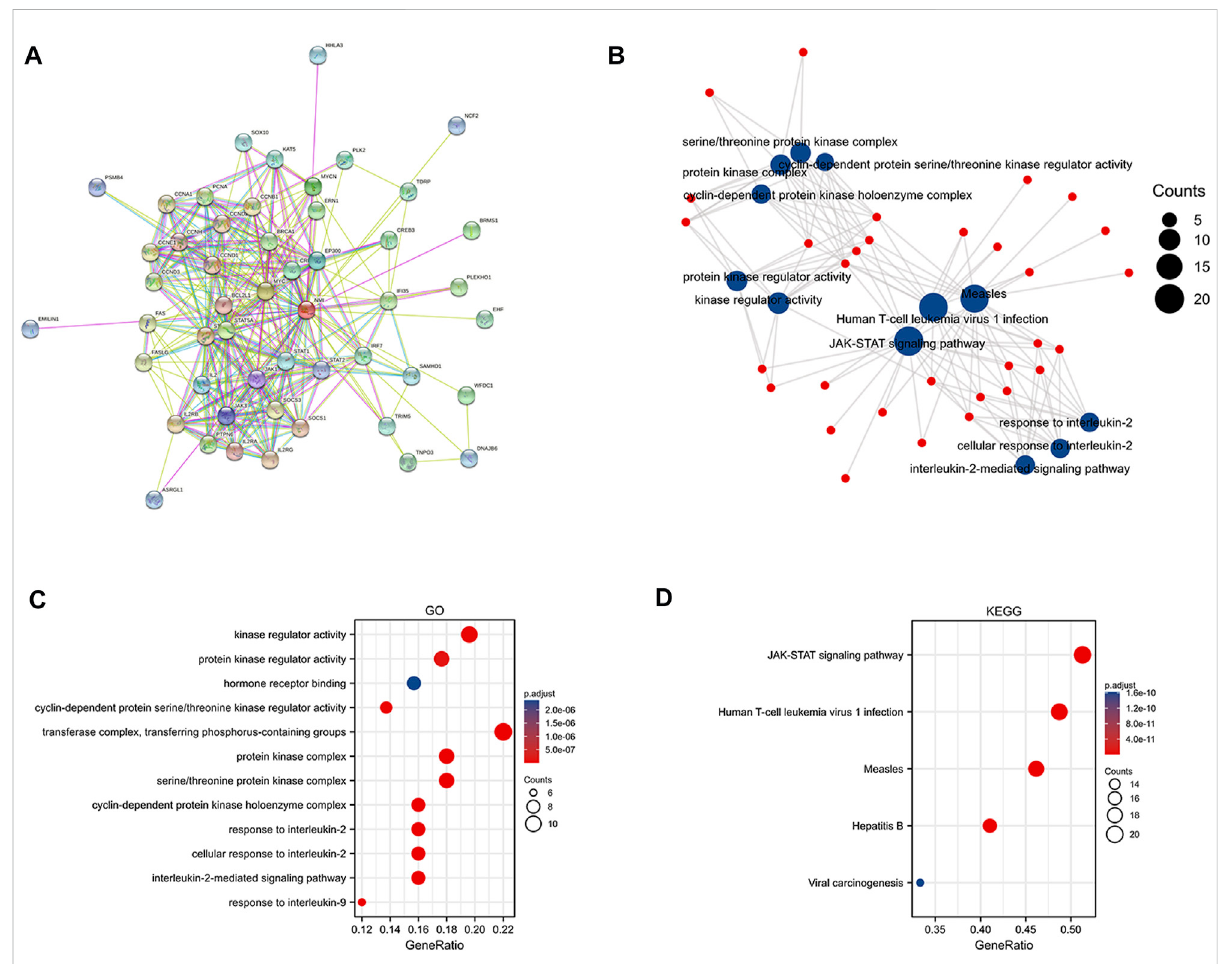
FIGURE 4 Functional enrichment analysis of NMI. (A) Protein network interaction diagram of NMI. (B) Scatter plot of GO and KEGG analyses of NMI interacting proteins (C) GO analysis of NMI-interacting proteins. (D) KEGG analysis of NMI-interacting proteins.